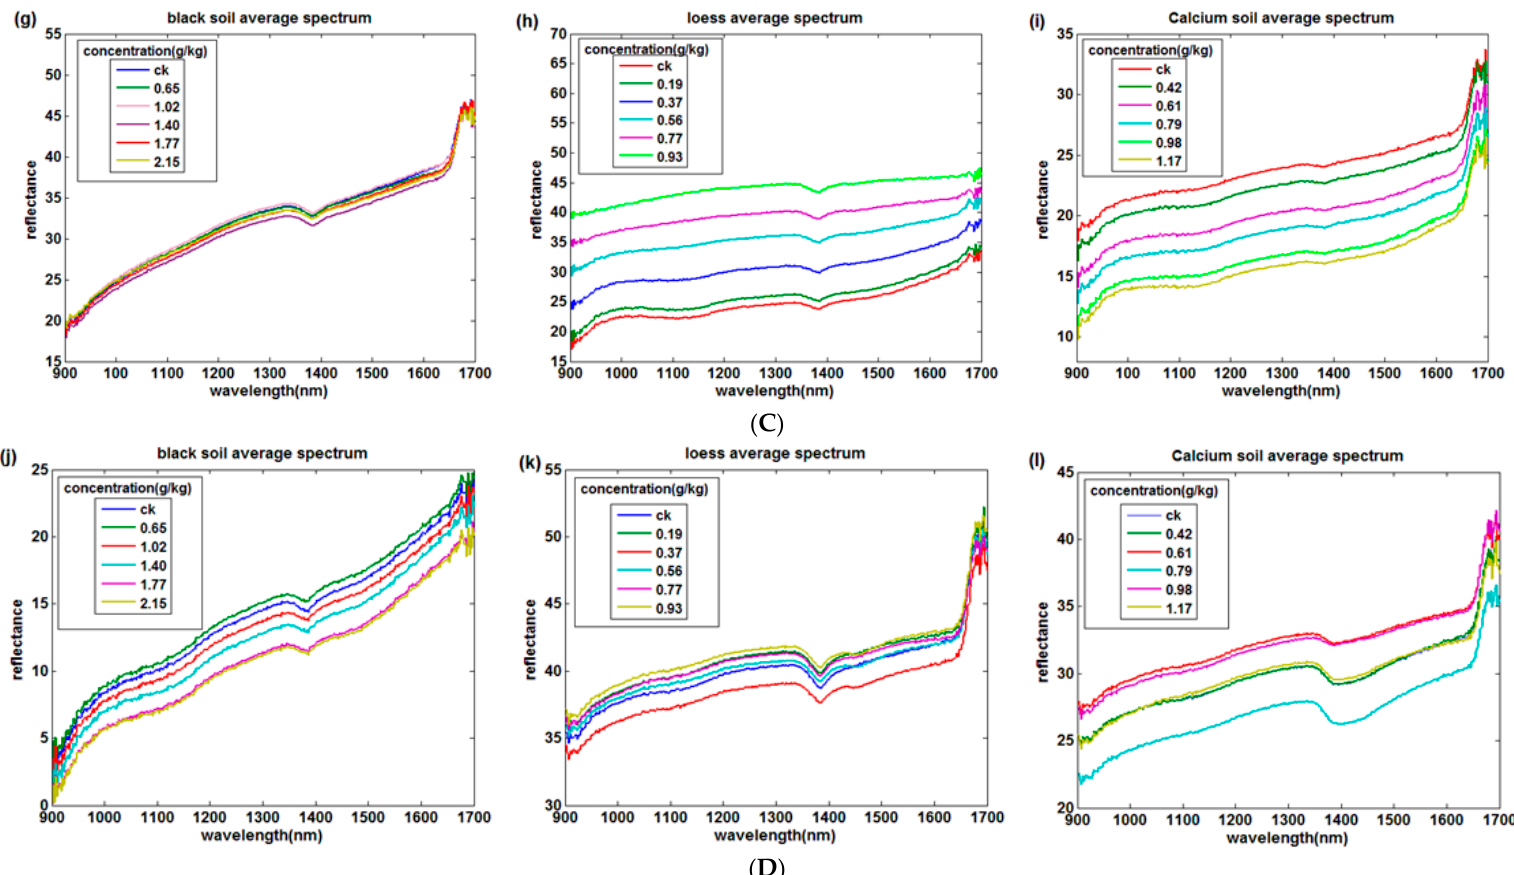
Figure 2. Near infrared spectra of three kinds of soils ( A ) 50 °C drying; ( B ) 80 °C drying; ( C ) 95 °C drying; ( D ) 25 °C placement. ( a , d , g , j ) are the black soil average spectrum at 50 °C, 80 °C, 95 °C drying and 25 °C placement respectively; ( b , e , h , k ) are the loess average spectrum at 50 °C, 80 °C, 95 °C drying and 25 °C placement respectively; ( c , f , j , l ) are the calcium soil average spectrum at 50 °C, 80 °C, 95 °C drying and 25 °C placement respectively.